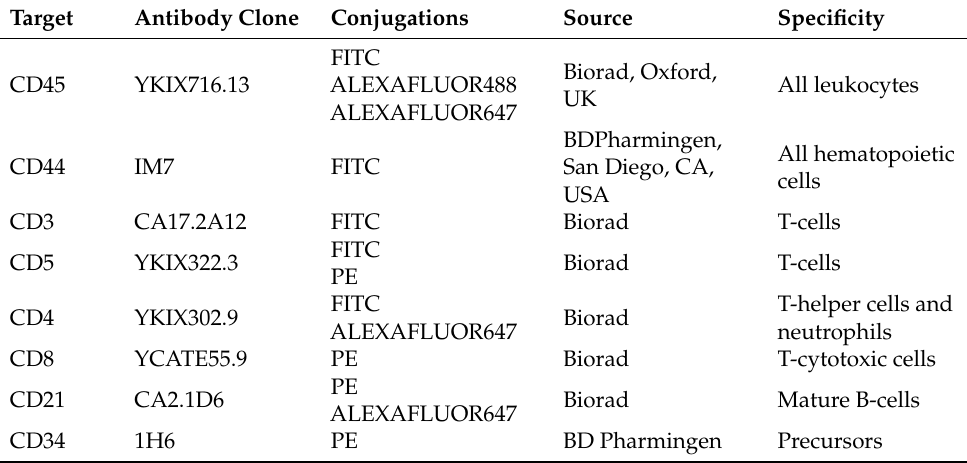
Table 1. Antibodies used for flow cytometric immunophenotyping of suspected canine lym- phoma